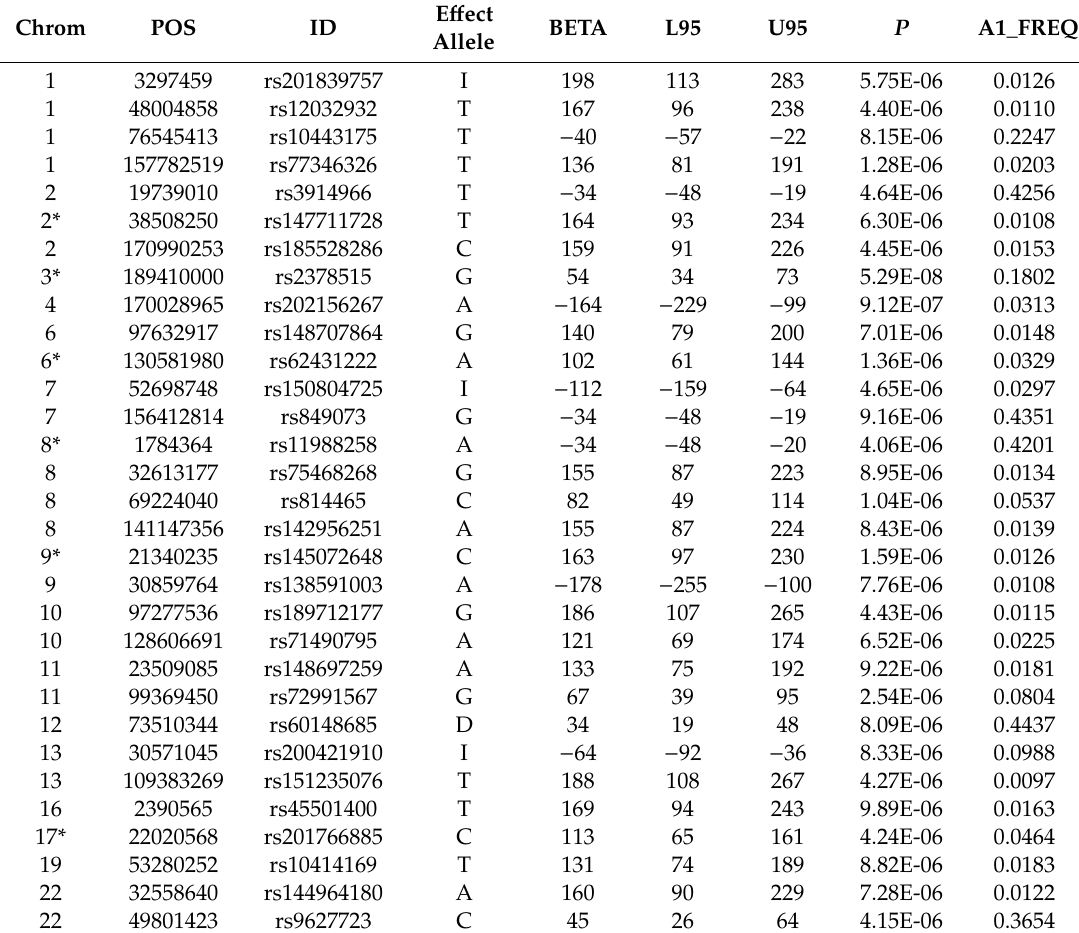
Table 2. Tag SNPs associated with adipose morphology with p < 10 − 5